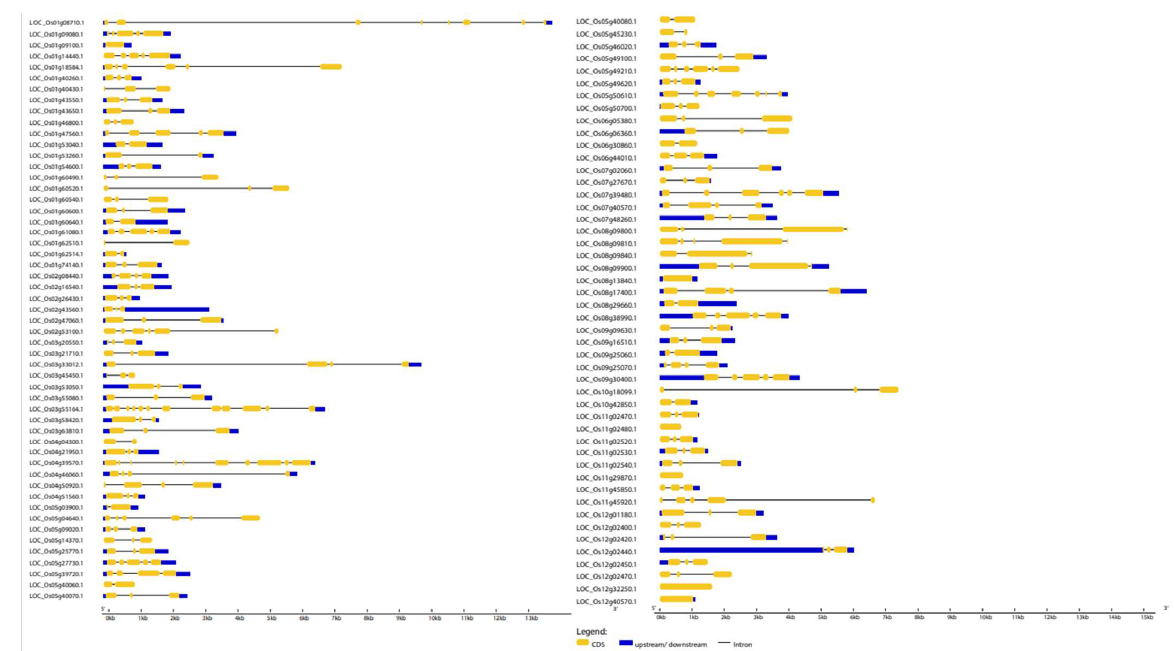
Figure 5. Exon–intron structure analysis of Oryza sativa WRKY genes was performed using the GSDS database. The blue boxes indicate upstream/downstream, the yellow boxes indicate exons, and the black lines indicate introns.